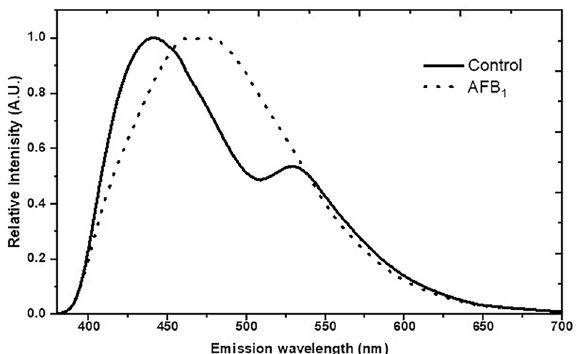
Figure 1. The normalized fluorescence emission spectra shown in solid and dashed lines correspond to control and aflatoxin B 1 -contaminanted Zea mays seeds, respectively. Excitation was set at 340